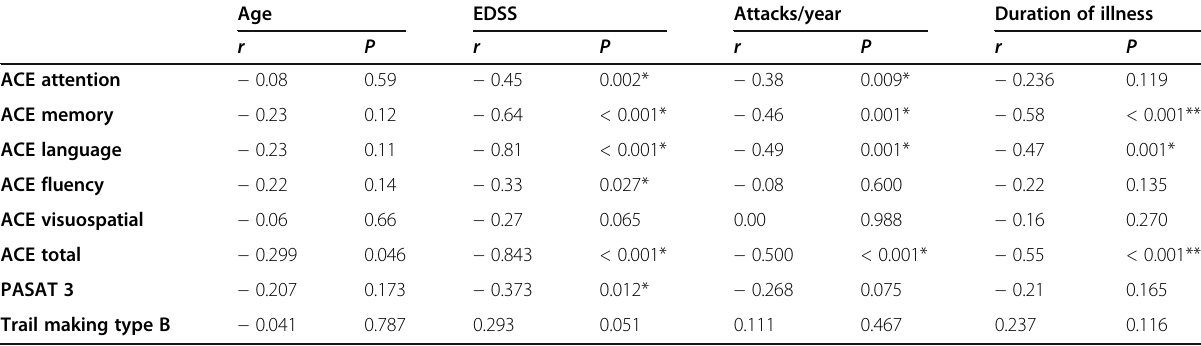
Table 7 Correlation between clinical parameters and scores of cognitive scales in MS patients Age EDSS